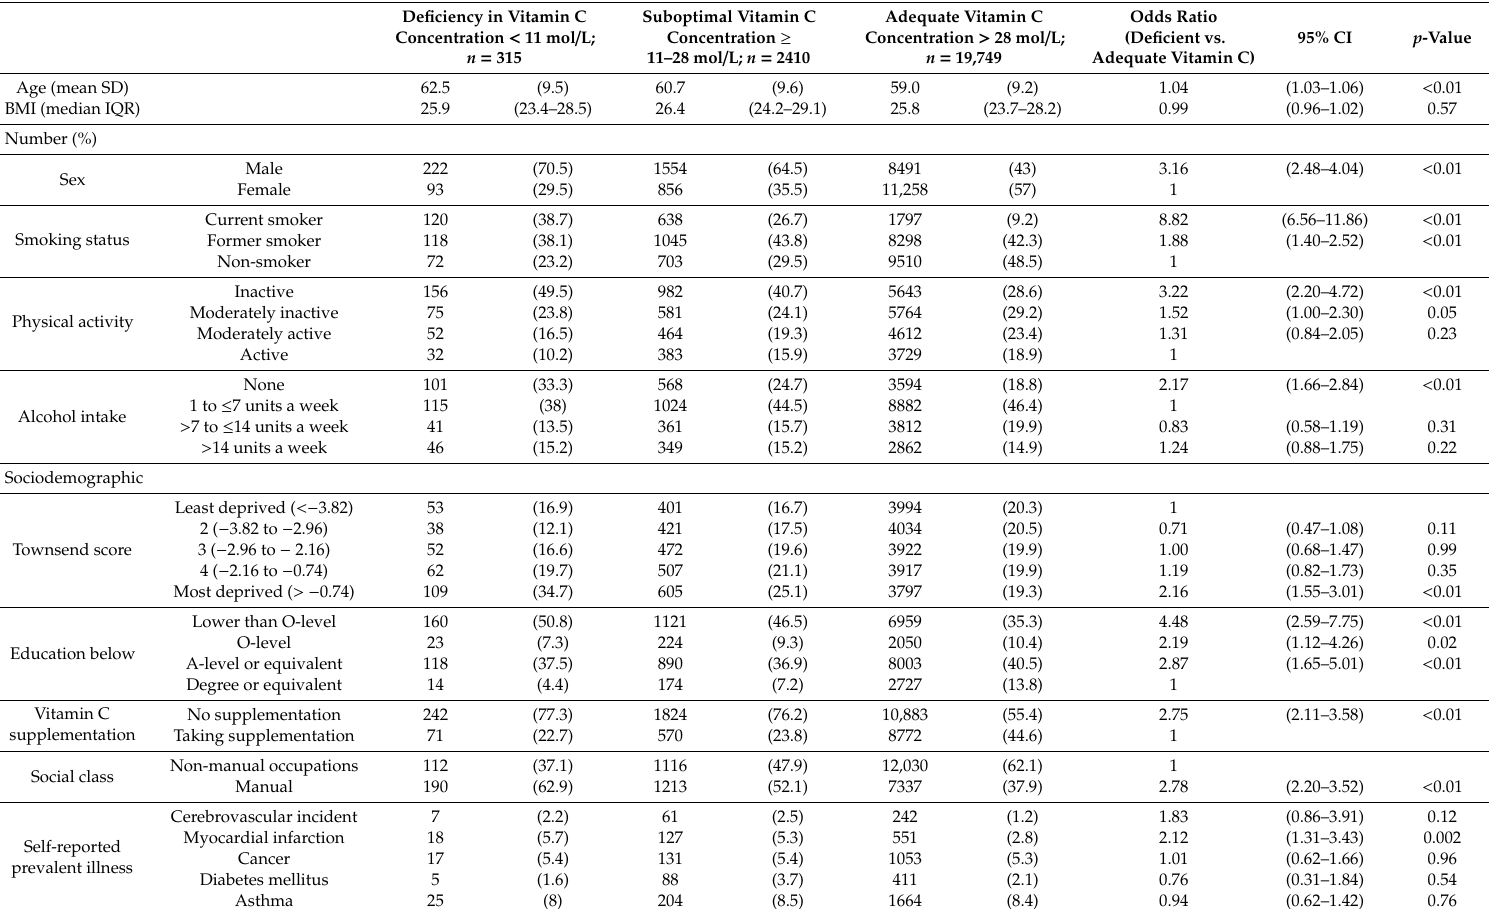
Table 1. Sociodemographic, lifestyle, and self-reported comorbidities by vitamin C deficiency